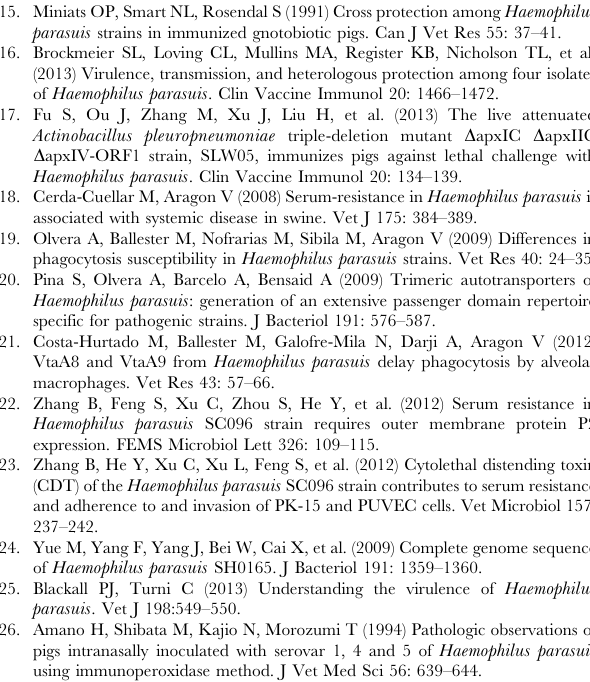
Table S2. Similarity of draft genome CDS sequences to